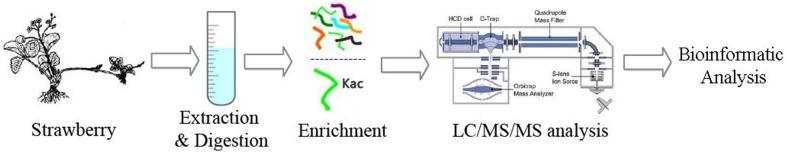
The workflow of integrated strategy for global mapping of lysine acetylation in strawberry leaves.